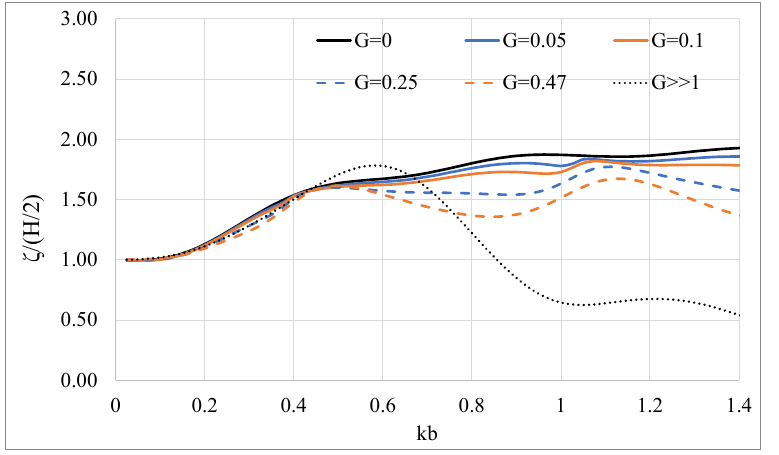
Figure 14. Effect of the porous coefficient 𝐺 on the wave run up on a floating porous compound cylindrical body.